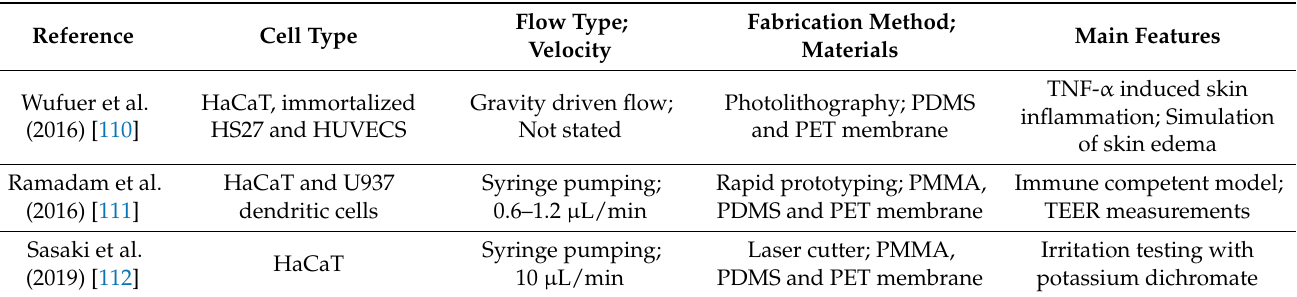
Table 1. Summary of the 2D SoC devices reported in the literature. Abbreviations: HUVECS, human umbilical vein endothelial cells; PDMS, polydimethylsiloxane; PEG, polyethylene glycol; PET, polyethylene terephthalate; PMMA, poly(methylmethacrylate); TEER, transepithelial electrical resistance; TNF, tumor necrosis